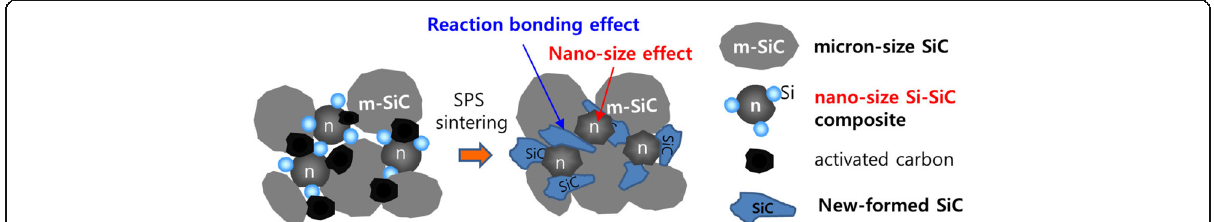
Fig. 9 Schematic drawing of sintering mechanism for micron-sized SiC powder with nano-sized Si-SiC composite powder and activated carbon as sintering